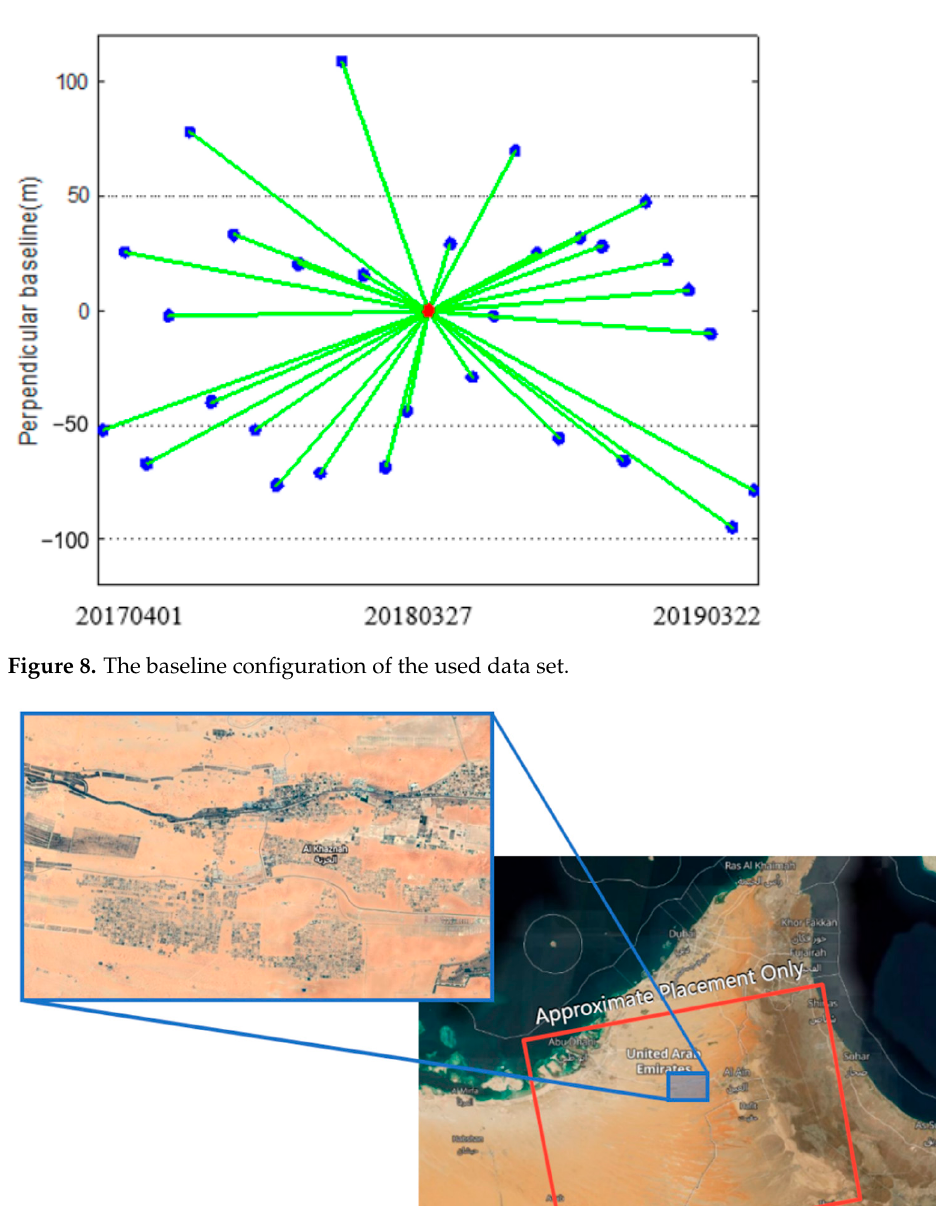
Figure 9. The test site located at Remah .